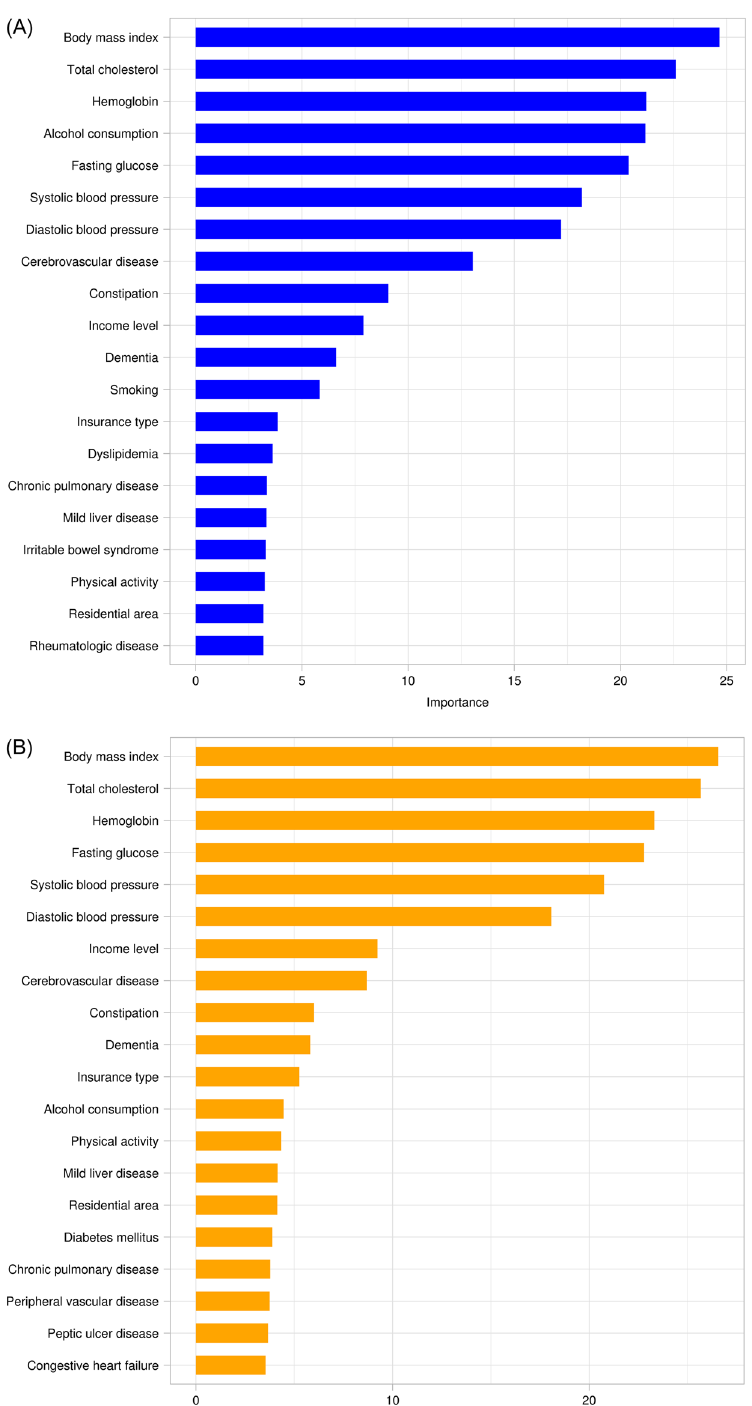
Figure 4. Feature importance for Parkinson’s disease prediction in the neural network algorithm by sex. ( a ) Male. ( b )